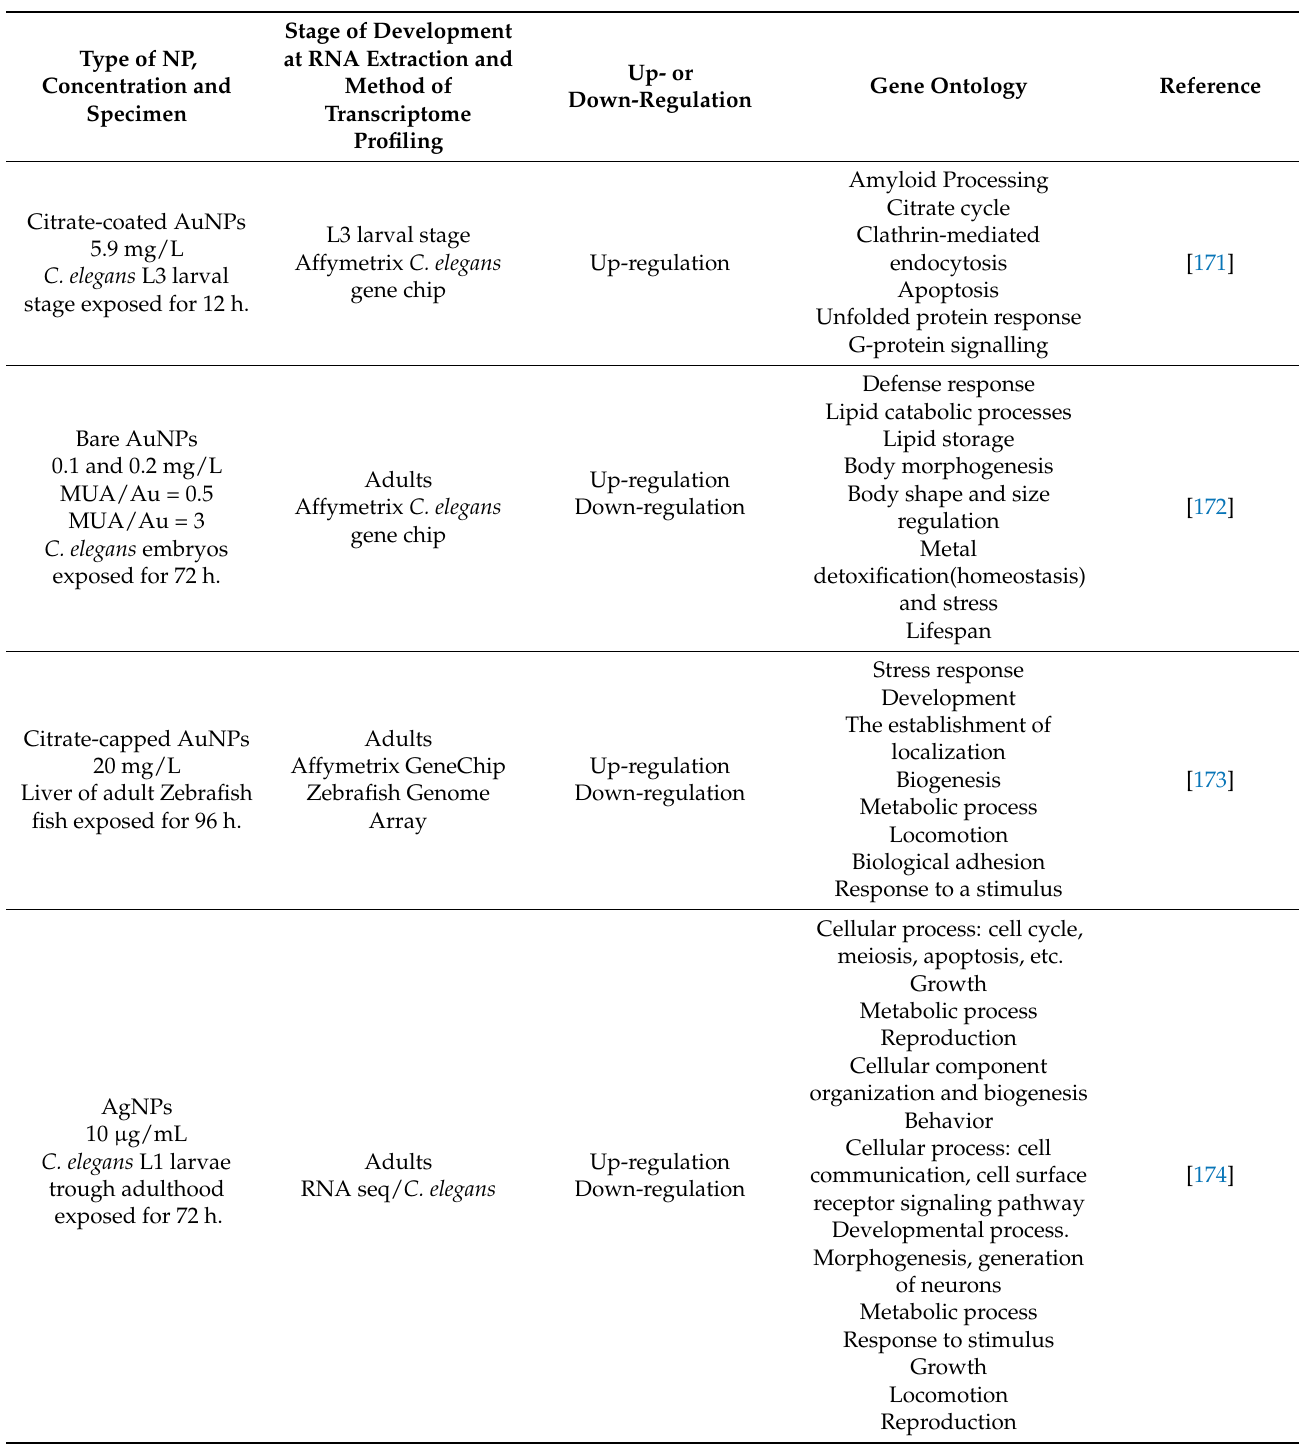
Table 2. Evaluation of AuNPs and AgNPs in C. elegans and Zebrafish; type of NP, concentration, specimen, stage of development, transcriptome profiling method, up or down regulation, and gene